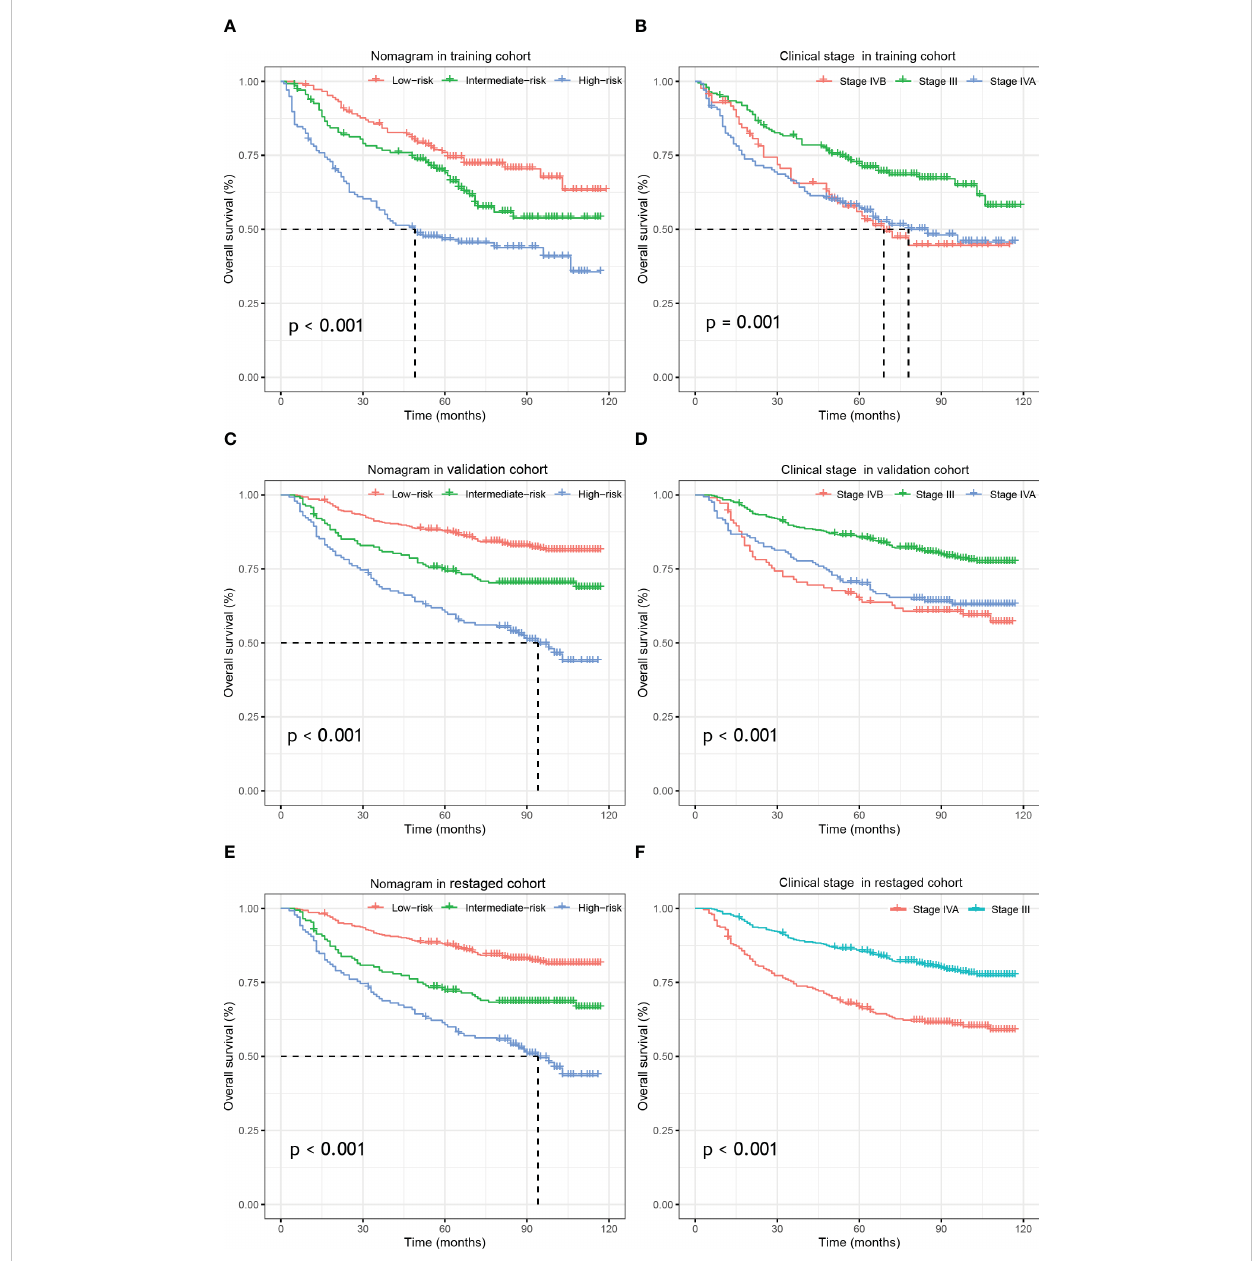
FIGURE 4 Kaplan – Meier survival analysis of overall survival according to the nomogram(left) and the clinical stage (right) strati fi cation in the training cohort (A, B) , external validation cohort (C, D) and re-staged cohort (E, F)